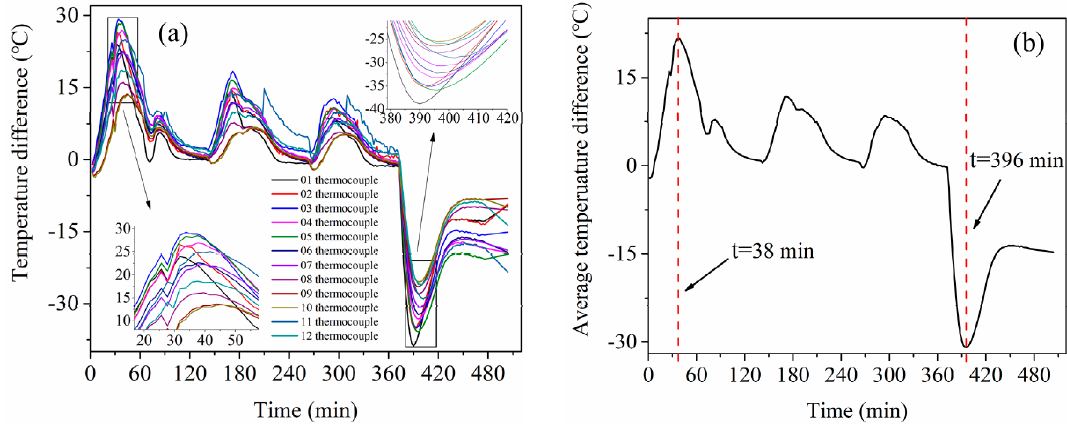
Figure 11. The temperature difference of 12 points between simulation and experiment. ( a ) The difference values, ( b ) the average difference.